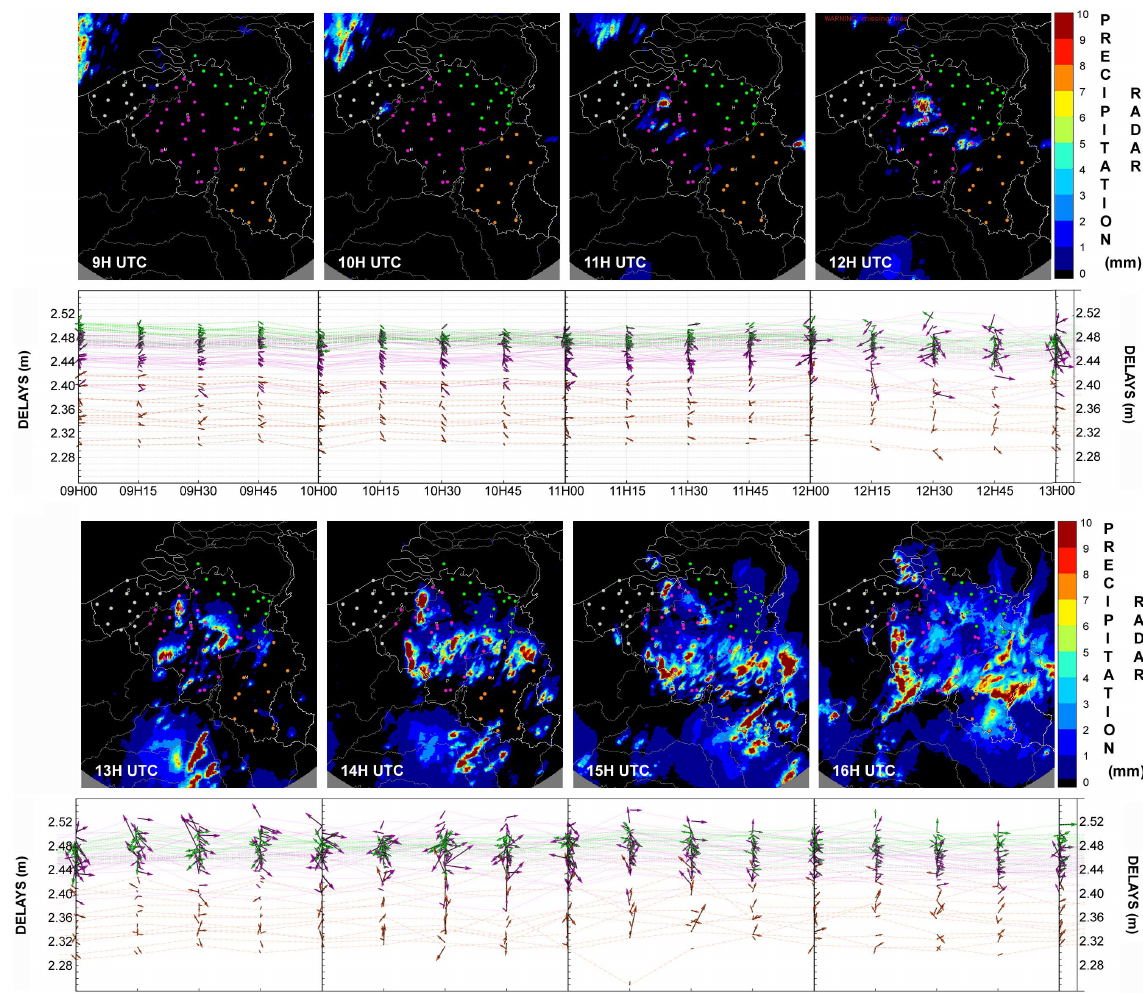
Figure 1. Sequence of hourly precipitation detected by radar from 09:00 to 24:00UTC (29 June 2005). GNSS stations are plotted on this map with 4 different colours dedicated to 4 geographical regions. Time series of GNSS horizontal gradients same 4 dedicated